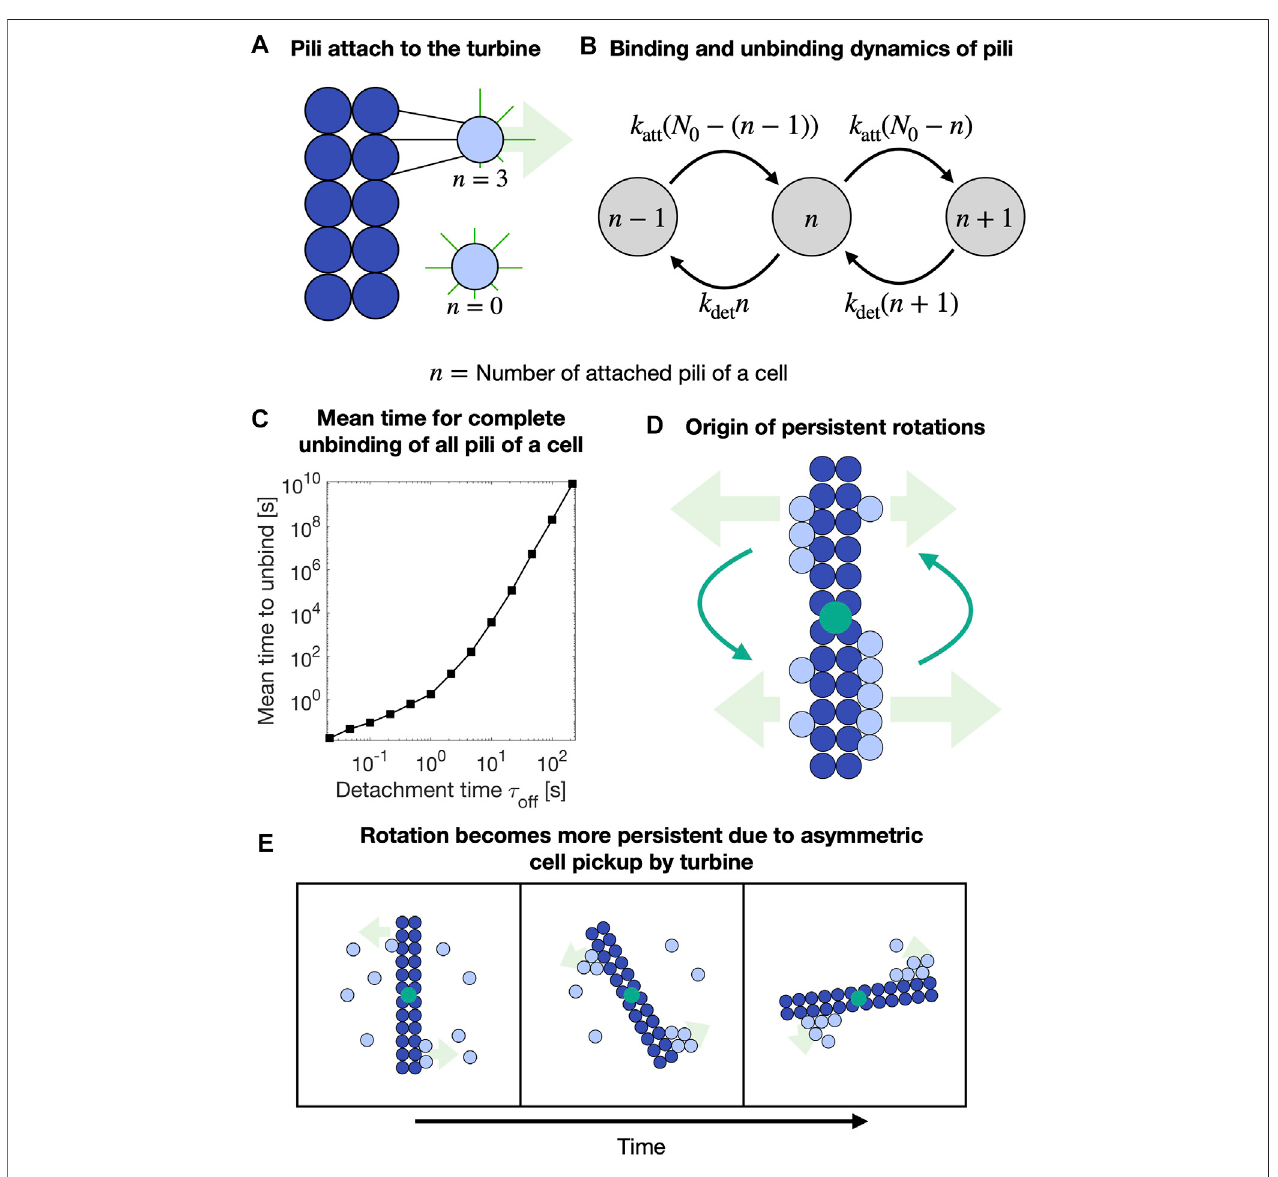
FIGURE4| Overview ofthemechanismdrivingthepersistentrotationoftheturbine. (A) A cell(lightbluecircle)with n =3or n =0piliattached toaturbine(darkblue circles). (B) Stochastic model of n pili attached to a turbine with pili binding (with constant rate k att ) and unbinding (with constant rate k det ). (C) Mean unbinding time to reach for the fi rst time the state n =0 in the stochastic model. Here, we chose N 0 =5, n ( t =0)=5, k att =2 Hz, k det =(exp1)/ τ off . (D) Sketch ofhow turbine rotation isaffected bymultiplecellsbindingtotheturbinesurface.Theturbinerotatesinthedirectioninwhichmorecellsareattachedtoitssurface(turbineispulledbycells). (E) Sketch of how turbine rotation leads to a pickup and binding of cells on the turbine